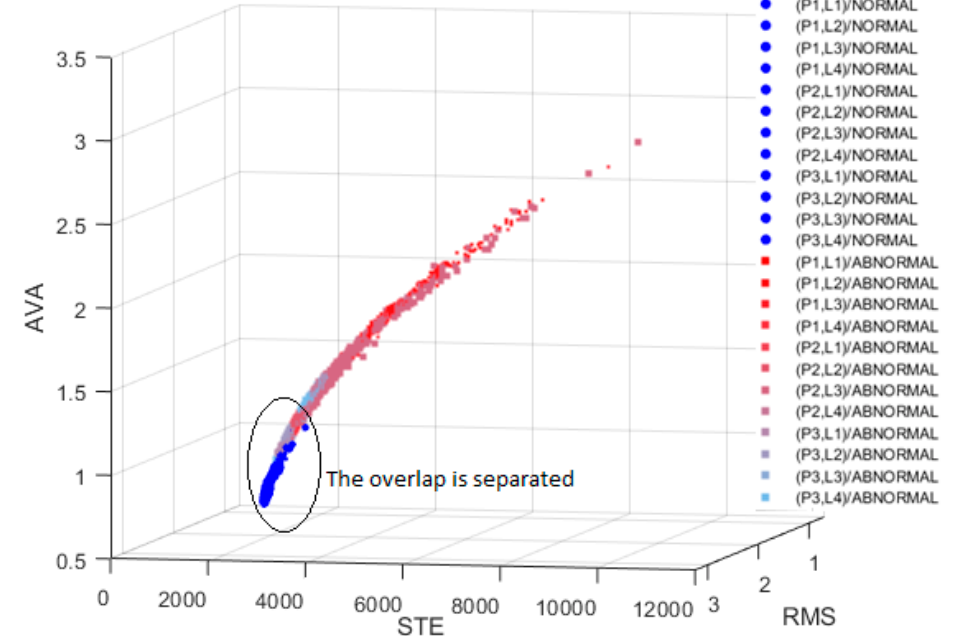
Figure 15. State scattering based on features extracted from g ( r ) .